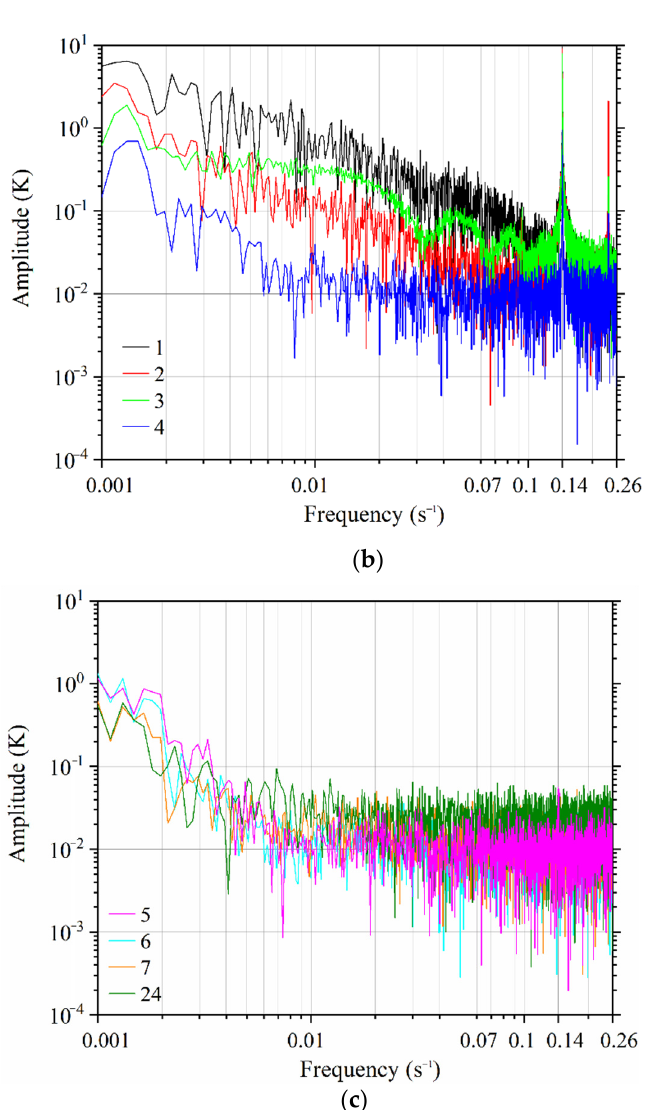
Figure 3. ( a ) TB observations at channel 1 over a SSMIS swath with observing times from 2114 UTC to 2256 UTC 7 August 2019. The 30th FOVs are linked by the black curve. There is a total of 3219 scanlines for this swath. ( b , c ) Spectral amplitude for the TB observations at the 30th FOV over this swath for ( b ) channels 1–4 and ( c ) channels 5–7 and 24. The amplitude has a spike at a frequency of 0.14 s − 1 . The interval between two scanlines is 1.9 s.